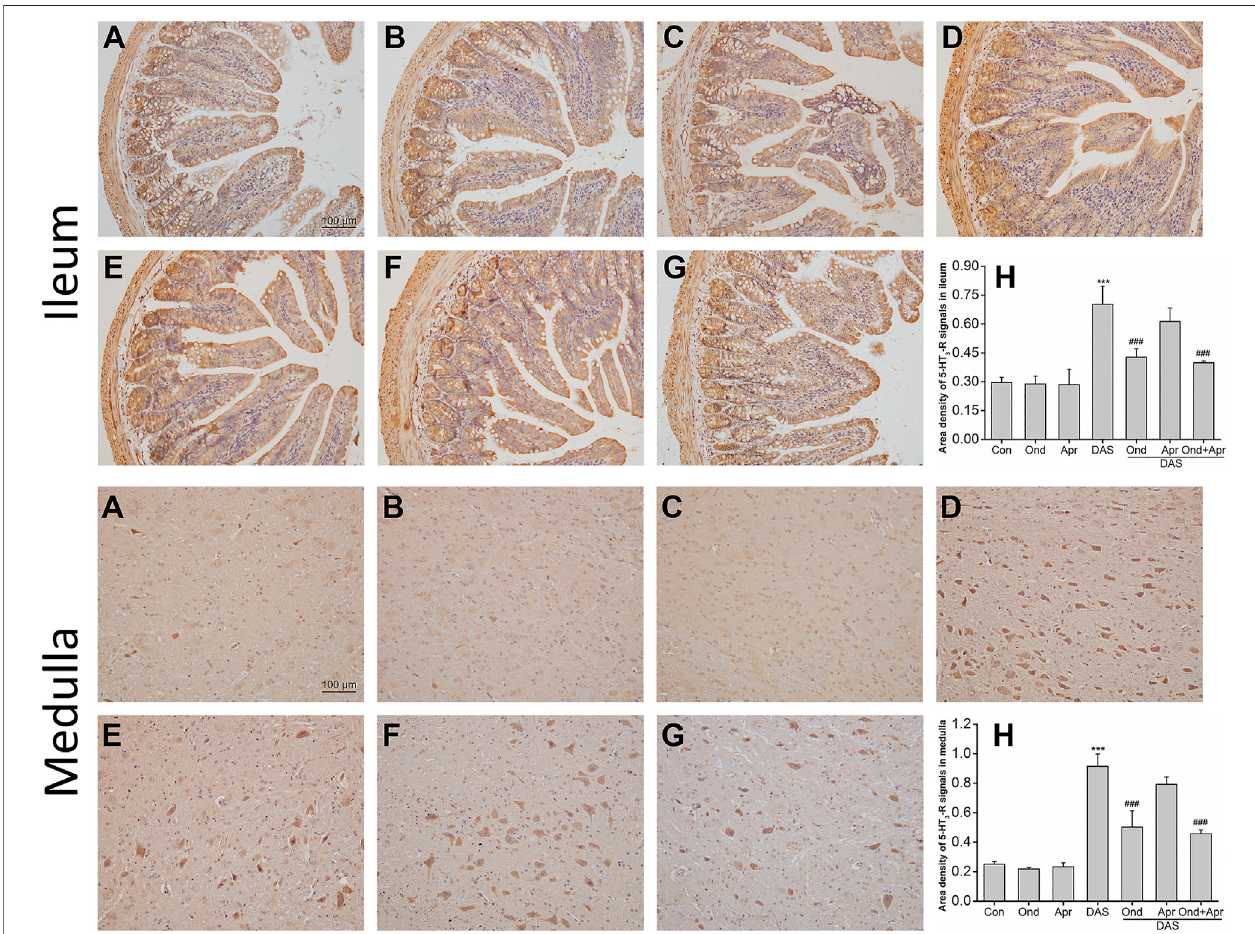
FIGURE9|T heeffectofOndandApronDAS-induced5-HT 3 receptorexpressionintheileumandmedullaofrats,4 haftertreatment:immunohistochemical(IHC) analysis (A) Control (B) Ond 1.66 mg/kg (C) Apr 26.2 mg/kg (D) DAS 2 mg/kg (E) DAS 2 mg/kg + Ond 1.66 mg/kg (F) DAS 2 mg/kg + Apr 26.2 mg/kg (G) DAS 2 mg/kg + Ond 1.66 mg/kg + Apr 26.2 mg/kg. Ond and Apr were administered 30 min before DAS. Semi-quantitative analysis of the ratio of 5-HT 3 receptor positive stainingtothetotal fi eld (H) .Dataareexpressedasmean ± SEM.Statisticalsigni fi cancewasassessedusingtheone-wayANOVA.* p < 0.05, ** p < 0.01, *** p < 0.001 vs. the control group, and # p < 0.05, # # p < 0.01, # # # p < 0.001 vs. the DAS